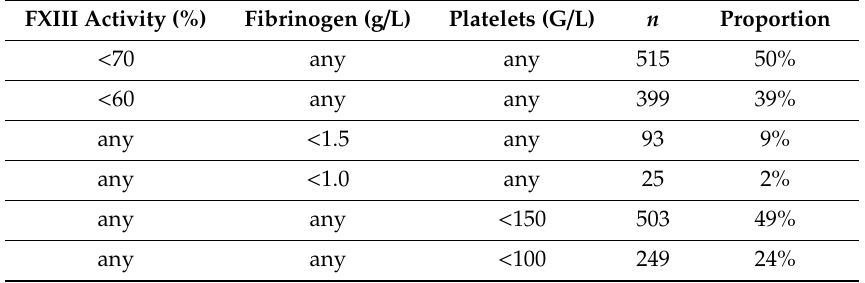
Table 1. Prevalence of overall factor XIII (FXIII) deficiency, fibrinogen deficiency, and